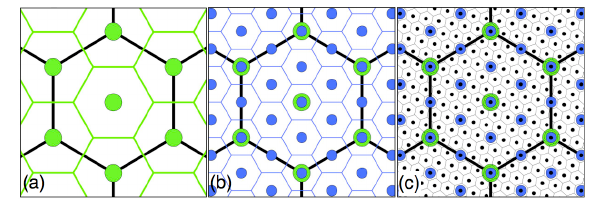
Figure 6. A portion of a precision 2 aperture 7 DGG system on an icosahedron constructed using sub-digit Figure 5. The addition of an aperture 3 grid precision in (a) allows each coarser precision cell vertex to be exactly represented. Assuming the central coarse precision cell has index A , it’s vertices are exactly A17 , A27 , ..., and A67 . The addition of an aperture 4 grid in (b) likewise allows the exact representation of each of the cell edge midpoints. Adding a final aperture 7 grid in (c) allows for sub-frequency addressing of cell interior points.